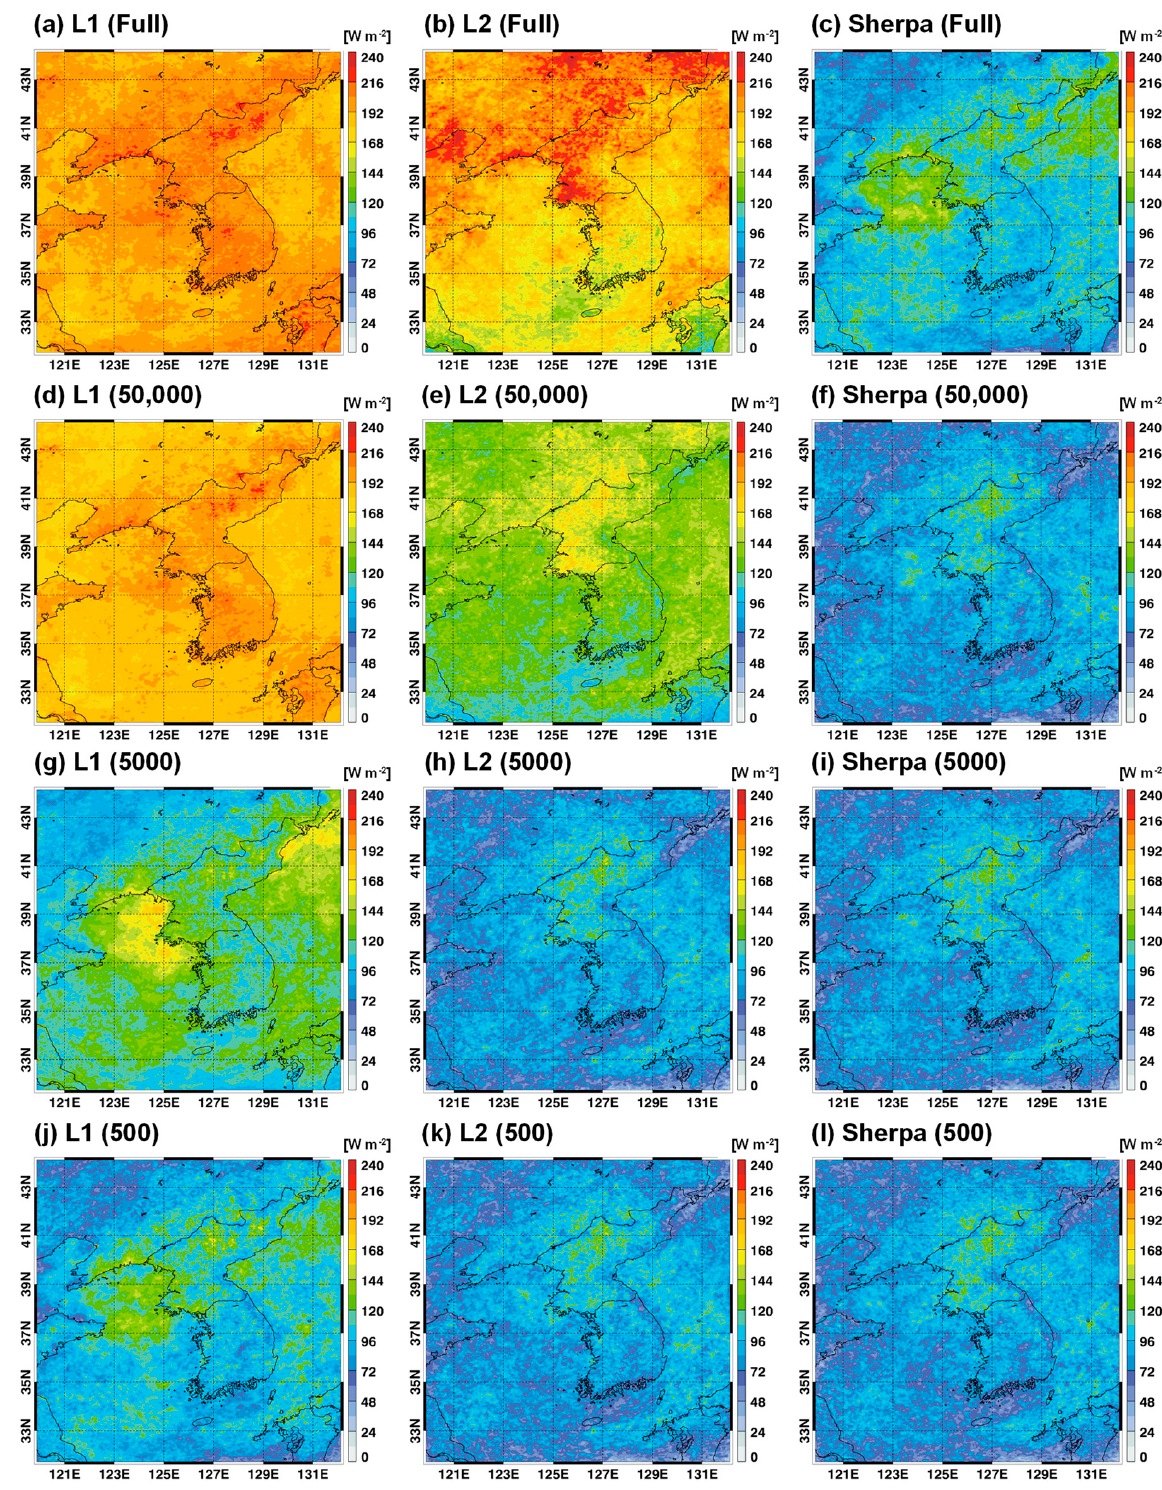
Figure 6. Spatial distributions of the root mean square errors (RMSEs) for SW flux simulated from radiation emulators based on different batch sizes ( a – c : Full, d – f : 50,000, g – i : 5000, j – l : 500) and learning rates (L1, L2, and Sherpa).